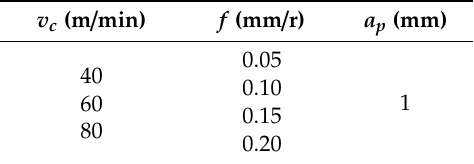
Table 2. Cutting